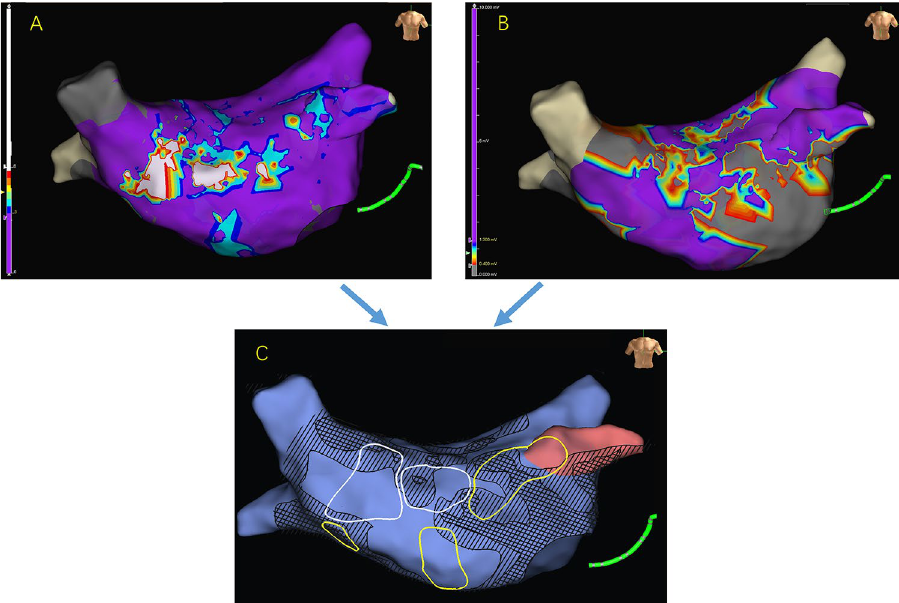
Figure 6. The relationship between C-EGMs and low voltage zones and transitional voltage zones. ( A ) a C-EGMs map of left atrium; ( B ) a voltage map of left atrium in the same patient; ( C ) the overlap between the C-EGMs region (the white circle indicate the fixed C-EGMs region and the yellow circle indicate the no-fixed C-EGMs region) and low voltage zones (grid areas) and transitional voltage zones (slashed areas). (Graphics software: Ensite Velocity and Microsoft Office PowerPoint